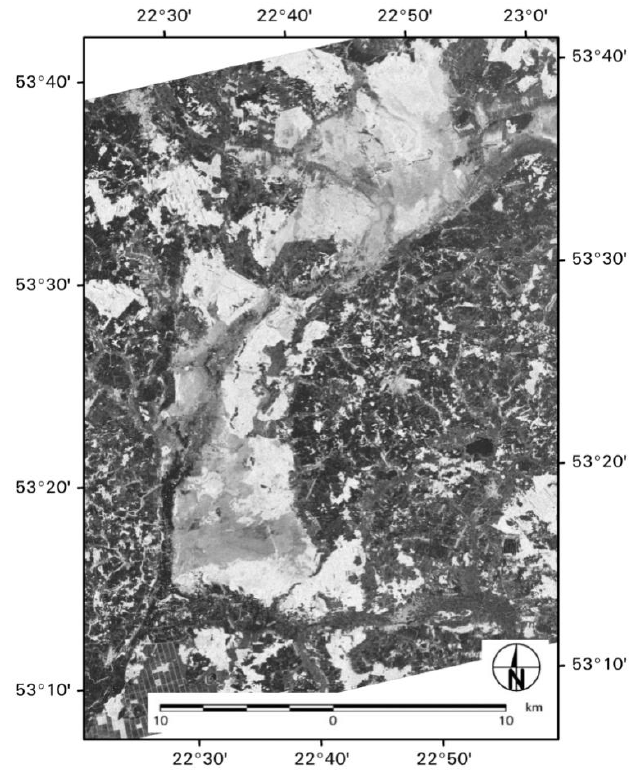
Figure 6. PALSAR FBD HV image acquired on 12 May